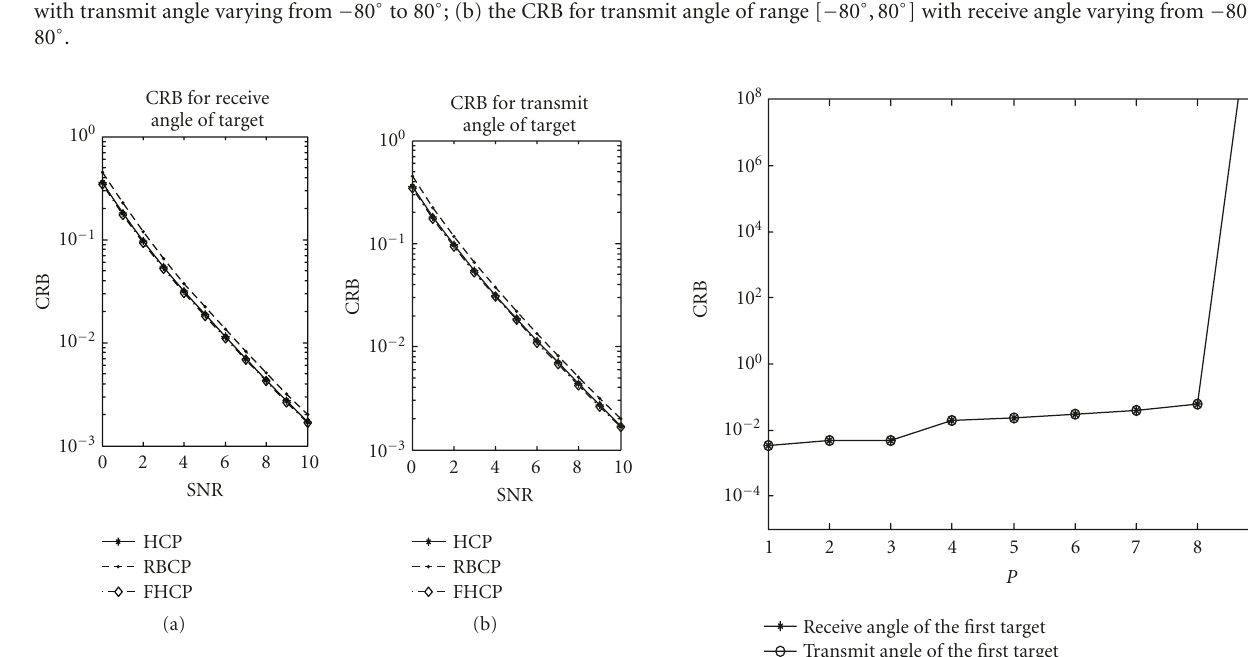
= 0 . 1. (a) The CRB for receive angle of range [ − 80 ◦ ,80 ◦ ] α